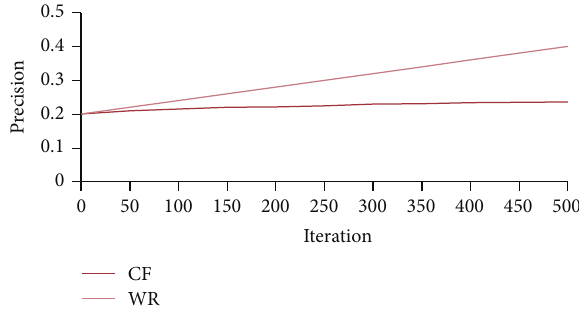
Figure 7: WebBluegillRecom-annealing system (WR) is compared to standard collaborative filtering (CF) system on coverage, 248 users.